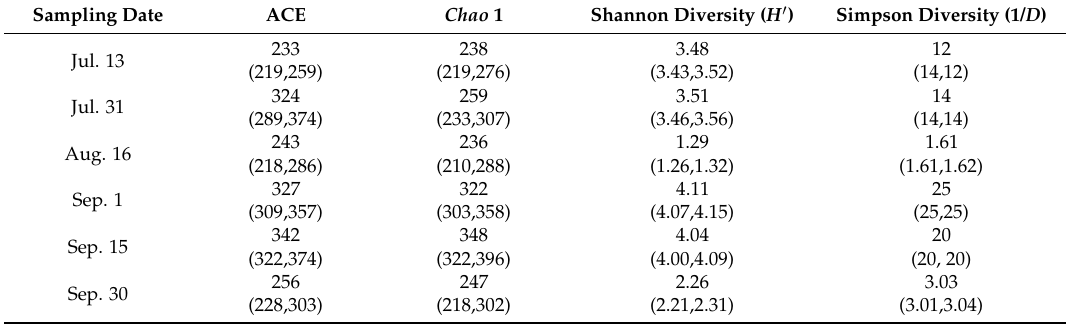
Table 4. Water fungal community diversity indices measured based on the Illumina MiSeq sequencing data of Zhoucun drinking water reservoir during algal bloom outbreak and decline from July to September,